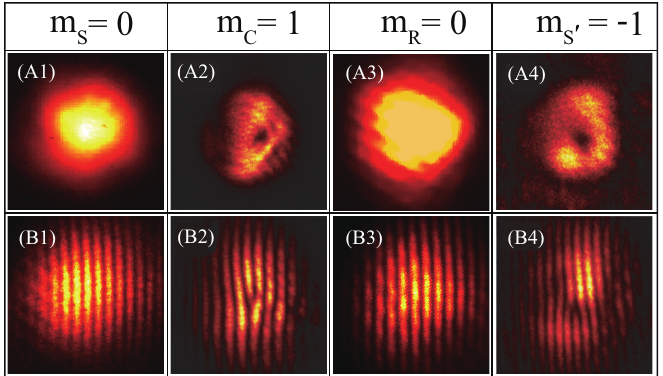
Figure 6. Transfer of OTCs from the coupling beam, E C , to the retrieved output signal pulse, E S (cid:48) . Here, m S = m C = 0 and m R = 1, and the OTC of the retrieved output signal pulse is m S (cid:48) = − 1. The first row shows the intensity distribution of each beam, while the second row shows the interference fringe of each beam with a plane wave (not shown in Figure 1). The forklike interference fringe indicates the phase singularity of the respective beam. Note that the forklike fringe of the retrieved output signal pulse points in opposite direction with respect to that of the coupling vortex, indicating that the sign of OTC is flipped. Figure partially adapted from reference [43].